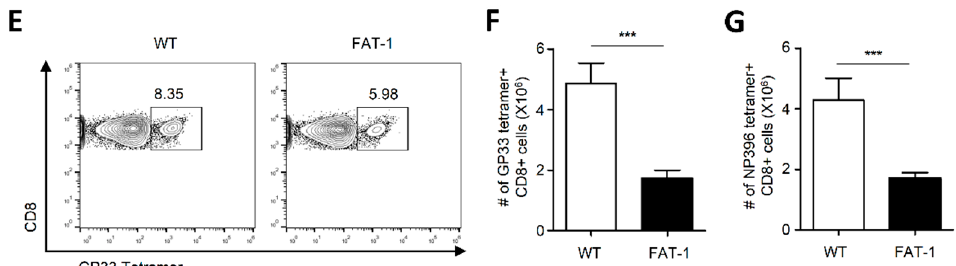
Figure 2. Anti-viral CD8 + T cell responses from spleen samples were suppressed in FAT-1 mice. WT and FAT-1 mice were infected with LCMV (Armstrong) for 7 days. ( A ) The number of CD3 + / CD8 + cells from each spleen is shown. ( B ) The surface expression of CD44 on CD8 + T cells was analyzed using flow cytometry. ( C , D ) Splenocytes from WT and FAT-1 mice were stimulated with LCMV GP33 (1 µ g / mL) peptide for 5 h followed by intracellular staining with anti-IFN- γ and TNF- α antibodies. The representative flow cytometry plots for expression of IFN- γ and TNF- α were shown ( C ). The frequency IFN- γ + TNF- α + CD8 + T cells are shown ( D ). ( E ) Splenocytes from WT and FAT-1 mice were stained with LCMV GP33 tetramer and the representative flow cytometry plots were shown. ( F , G ) The numbers (#) of LCMV GP33 ( F ) and NP396 ( G ) tetramer + cells were graphed. The data represent the mean ± SEM ( n = 4–8 mice per group). * p ≤ 0.05; *** p ≤ 0.001. The experiments were repeated at least three times with similar results.